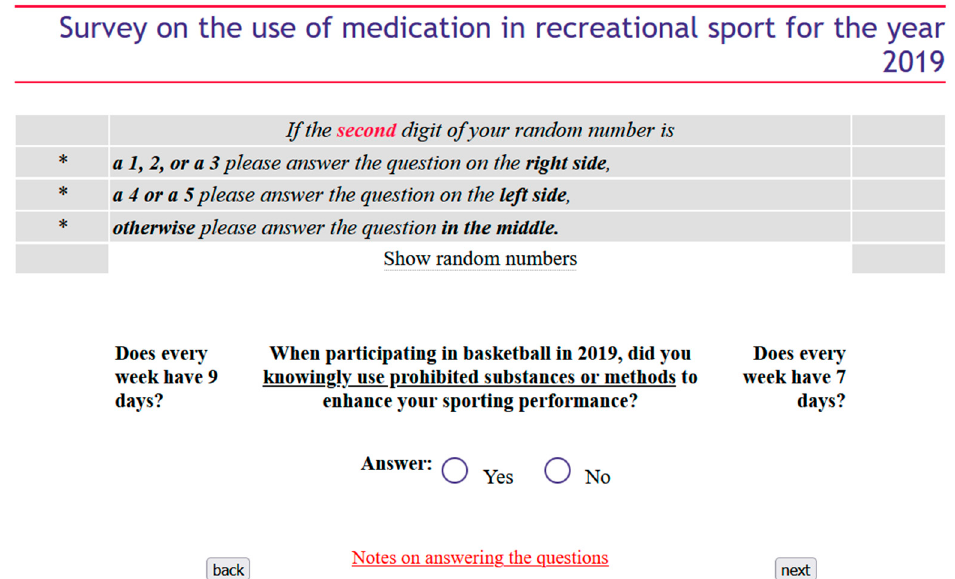
Figure 1. Example of an RRT question on doping in recreational sport from the FAIR+ survey. For the full survey, see https://fp.socioeconomy.eu/index.php (accessed on 28 November 2022).